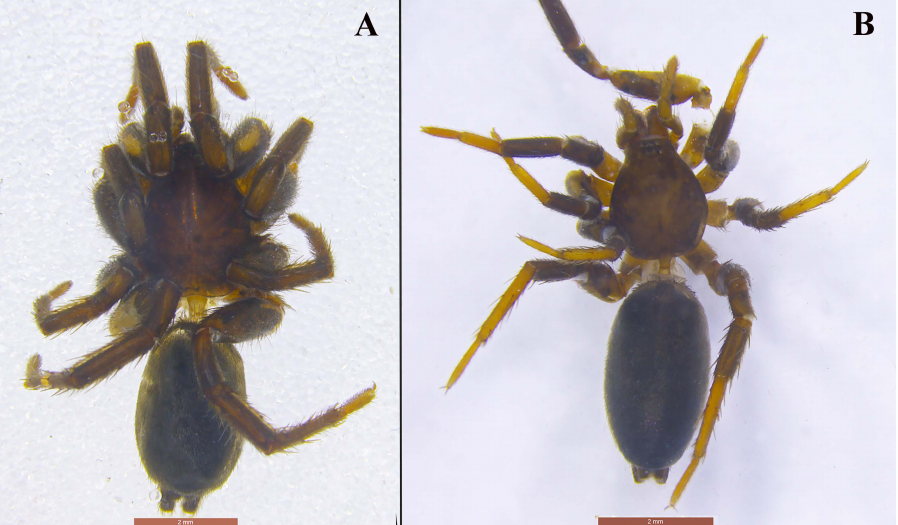
Figure 14. Zelotes histio n.sp., habitus. ( A ) Holotype (fully mature), ( B ) penultimate form (FC: 17147).